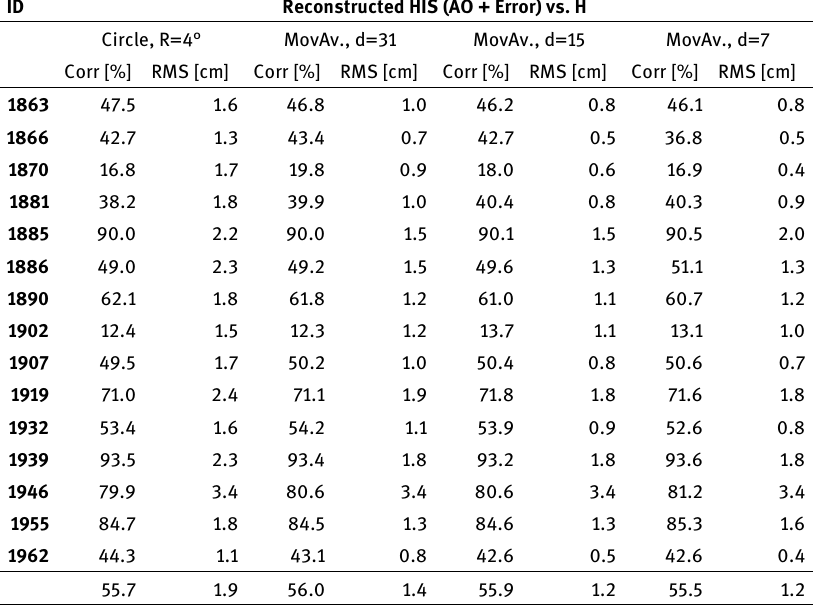
Table 7. Correlation [%] and RMS [cm] of reconstructed HIS signal to the original ESA ESM HIS for the 15 selected study cases with a moving average applied (d/o 30, circles R=4 ◦ ). ID Reconstructed HIS (AO + Error) vs. H Circle,